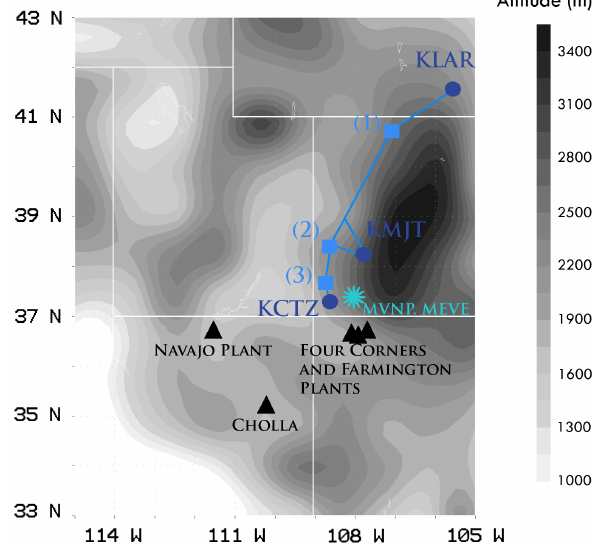
Fig. 1. Detail map of the western United States centered on the Colorado Western Slope. Topography is contoured. The location of the Mesa Verde field site is indicated with a teal star. King Air flight tracks are shown in light blue and the vertical stack locations are given by squares. The vertical stack locations are (1) Steamboat Springs, (2) Nucla, and (3) Cortez. Several local coal-fired power stations are marked with black